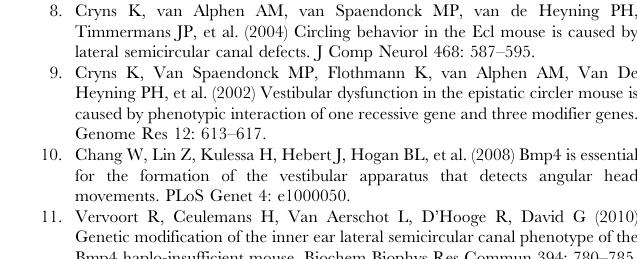
Figure S2 Mapping and sequence analysis of the Rubie insertion. The retroviral insertion in intron 1 of Rubie was mapped using a PCR-based strategy. Horizonatal bars represent- ing individual PCR products are shown in relation to their location in intron 1, and are flanked by names of the primers used to generate them. Green bars represent products that were easily amplified by conventional PCR from both C57BL/10J and SWR/ J genomic DNA. Red bars represent products that were robustly amplified in C57BL/10J, but could not be amplified by conventional PCR in SWR/J. The vertical gray bar depicts the region in which an insertion or chromosomal rearrangement must occur. The sequence of this 27 bp region is shown above (underlined). Long-range PCR between primers H-F1 and MapR7 revealed that the SWR/J allele contains a 5542 bp endogenous retrovirus (blue sequence), flanked by a 6 bp target site duplication (red sequence), a hallmark of retrotransposition. Table S1 Genomic Locations and Sequences of Rubie Exons. Table S2 Sequences of Oligonucleotide